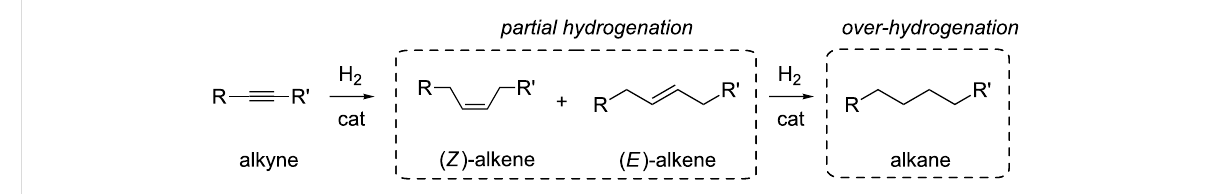
Scheme 1: Common reaction pathways for alkyne hydrogenation